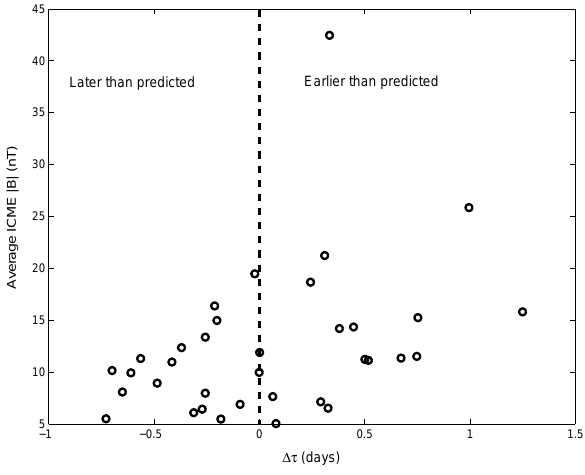
Fig. 5. The average magnetic field intensity of an ICME as a func- tion of 1τ (predicted – actual τ ). Late arriving ejecta have lower magnetic field intensities than early ones.